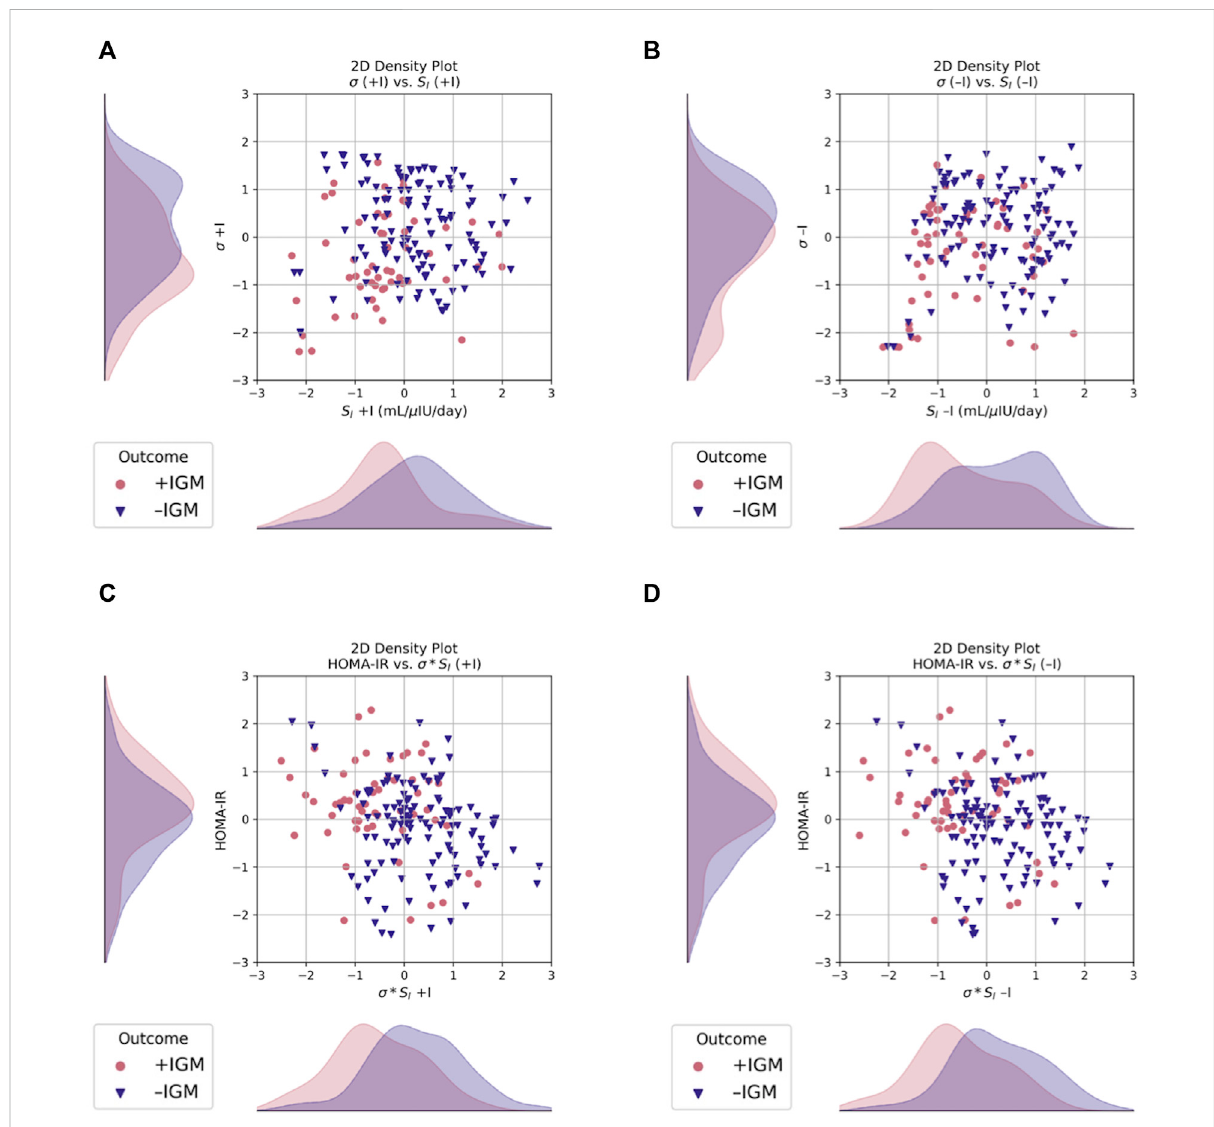
FIGURE 2 Scatter and 2D kernel density estimation plots, strati fi ed by post-operative outcome at 12 months. Data are shown after Box-Cox transformation for visualization. (A) Incorporating measured insulin measurements in the data assimilation estimations increases separation of the estimated probability distributions of σ between groups, as compared to (B) without insulin, where S I is more separated but σ has more overlap. (C) σ